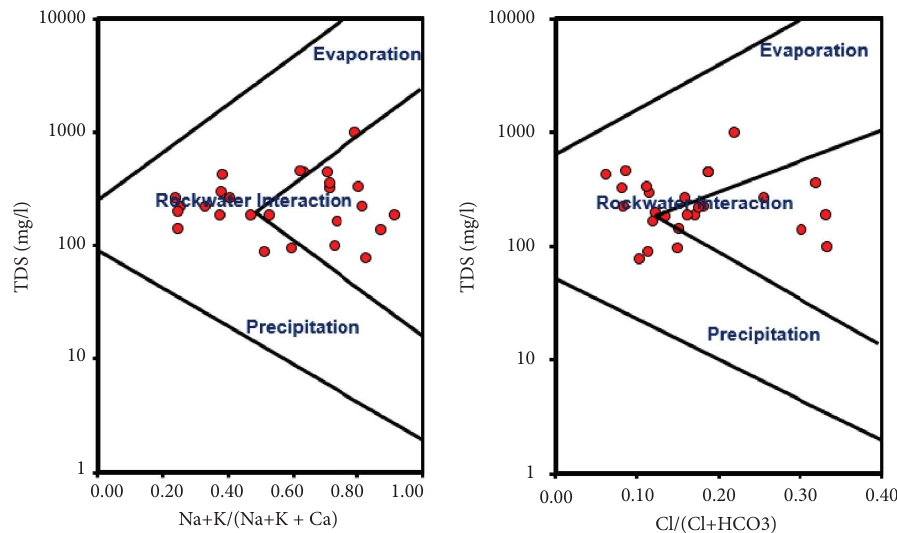
Figure 18: Mechanisms governing groundwater chemistry in the Gibbs